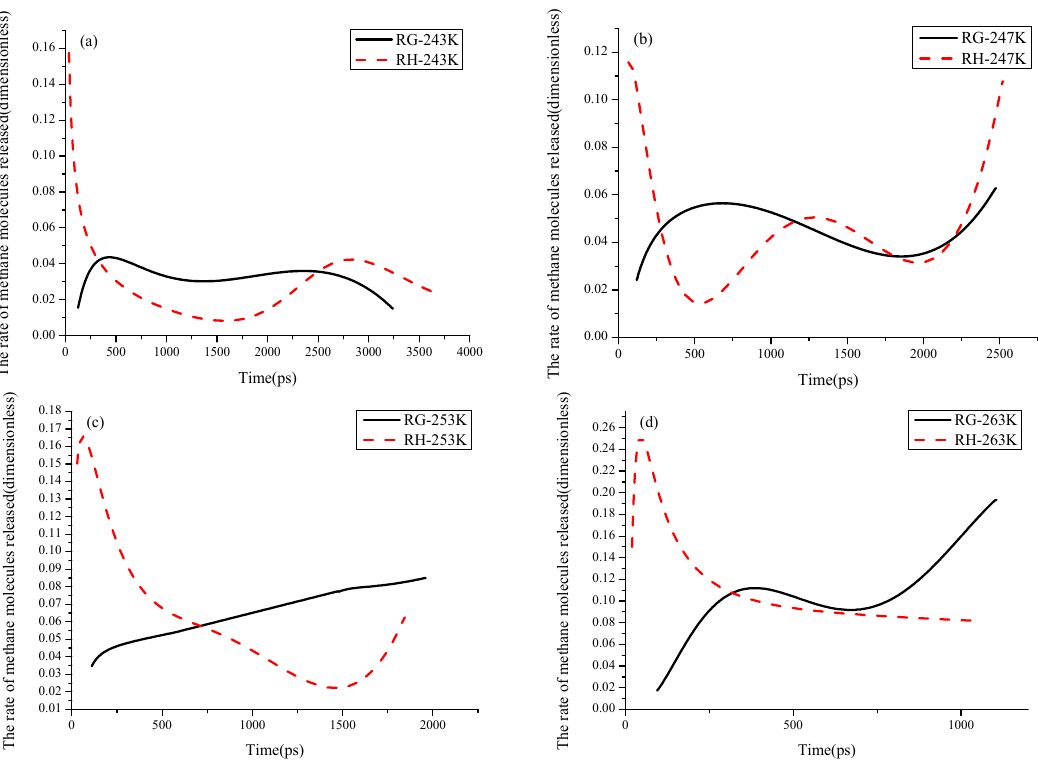
Figure 6. The rate changes of CH 4 molecules released from liquid and gas side in different simulation temperature. ( a ) in 243 K, ( b ) in 247 K, ( c ) in 253 K, ( d ) in 263 K.